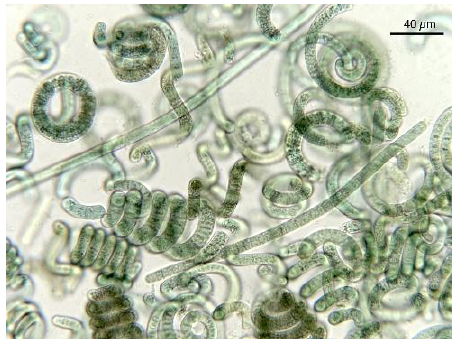
Figure 8. Spirulina product showing the presence of Oscillatoria sp. (long linear cells).